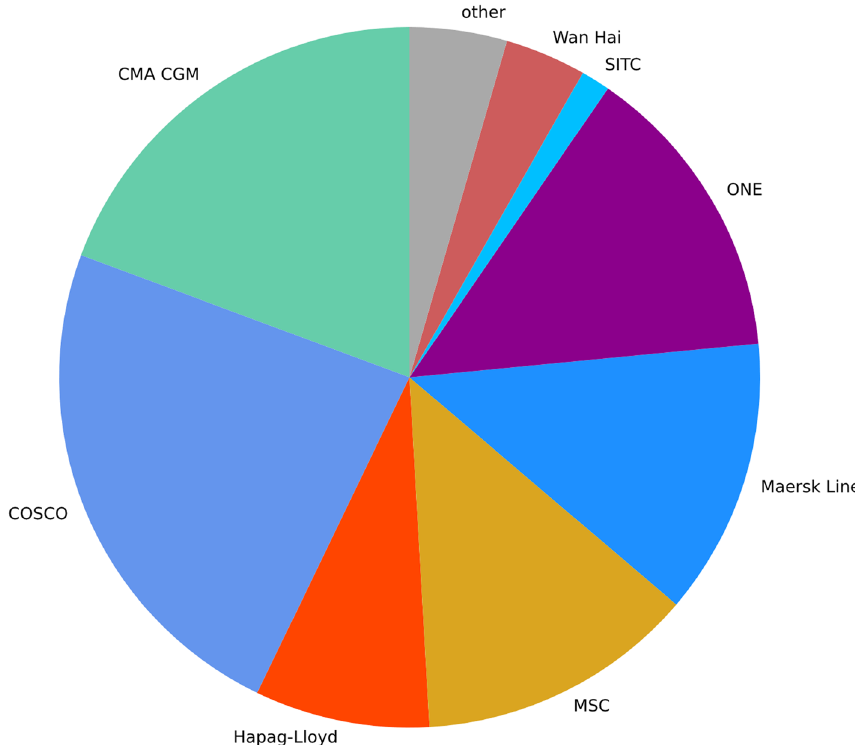
Fig. 4 Share of liner shipping companies by number of movements. Source : Own figure